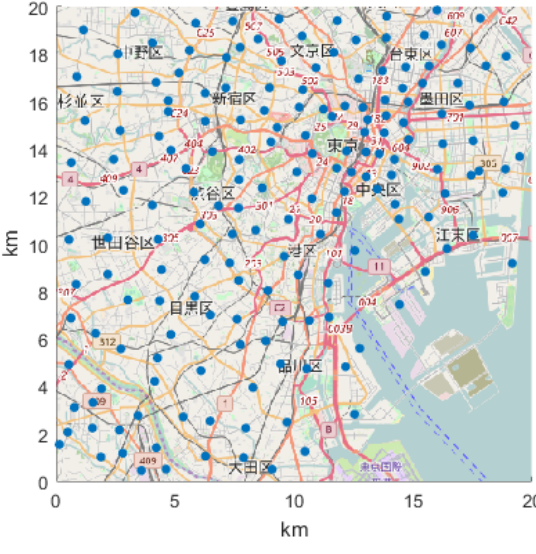
Figure 3. Map of origin/destination nodes in central Tokyo, taken from transport survey [32]. Map from